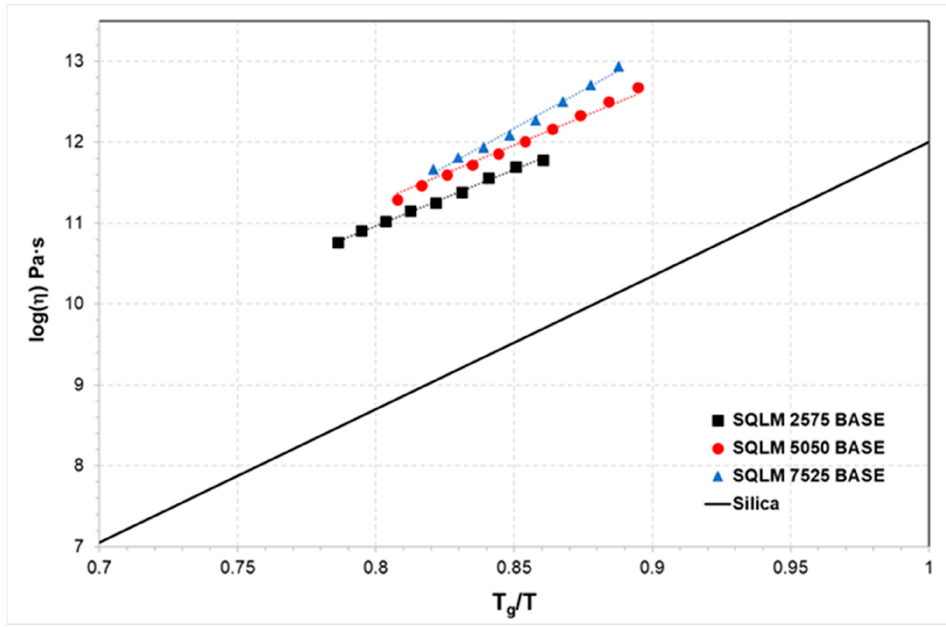
Figure 8. Angell fragility plot of the logarithm of the viscosity as a function of the inverse temperature, scaled to T g for the different materials catalyzed by BGDBU. For comparative purposes, the black continuous line, which is the relation for silica, has been included [27].